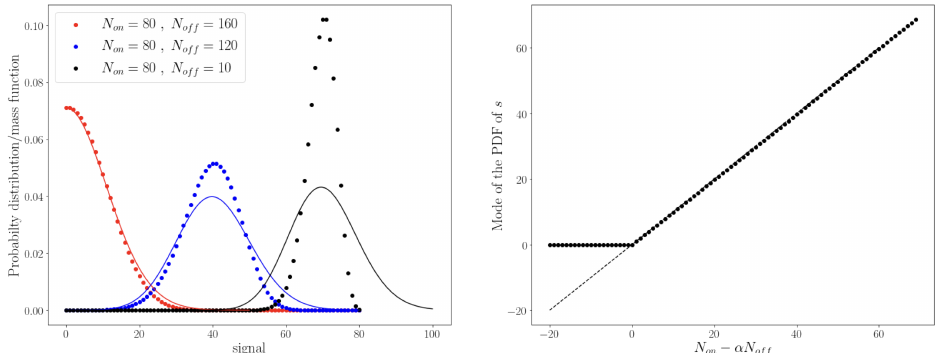
Figure 7. Left panel : Points show the PMF defined in Equation (35) of the number of signal events N s , while lines show the PDF defined in Equation (34) of the expected signal counts s . Different colors are used to distinguish the different counts N of f (160 in red, 120 in blue and 10 in black), while N on and α are fixed to 80 and 0.5, respectively. Right panel : The mode of the PDF defined in Equation (34) as a function of the excess N on − α N of f . As a dashed line the equation x = y is shown for